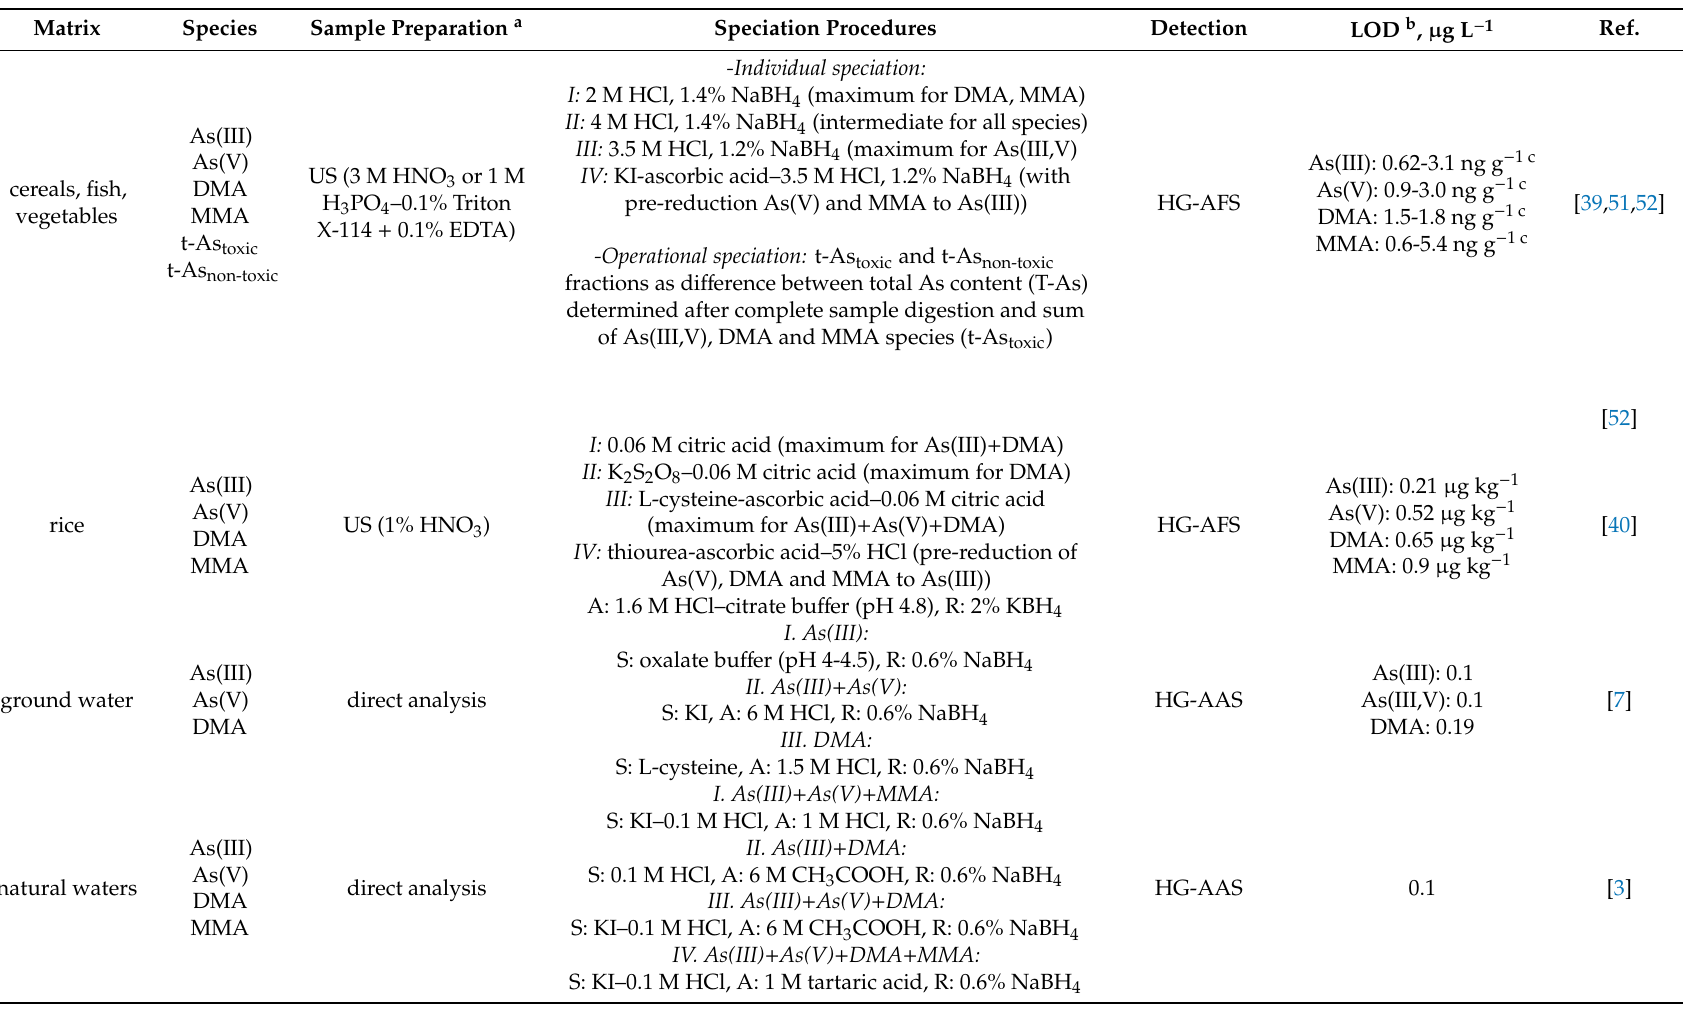
Table 4. Non-chromatographic speciation and fractionation protocols for the determination of various As species by HG.